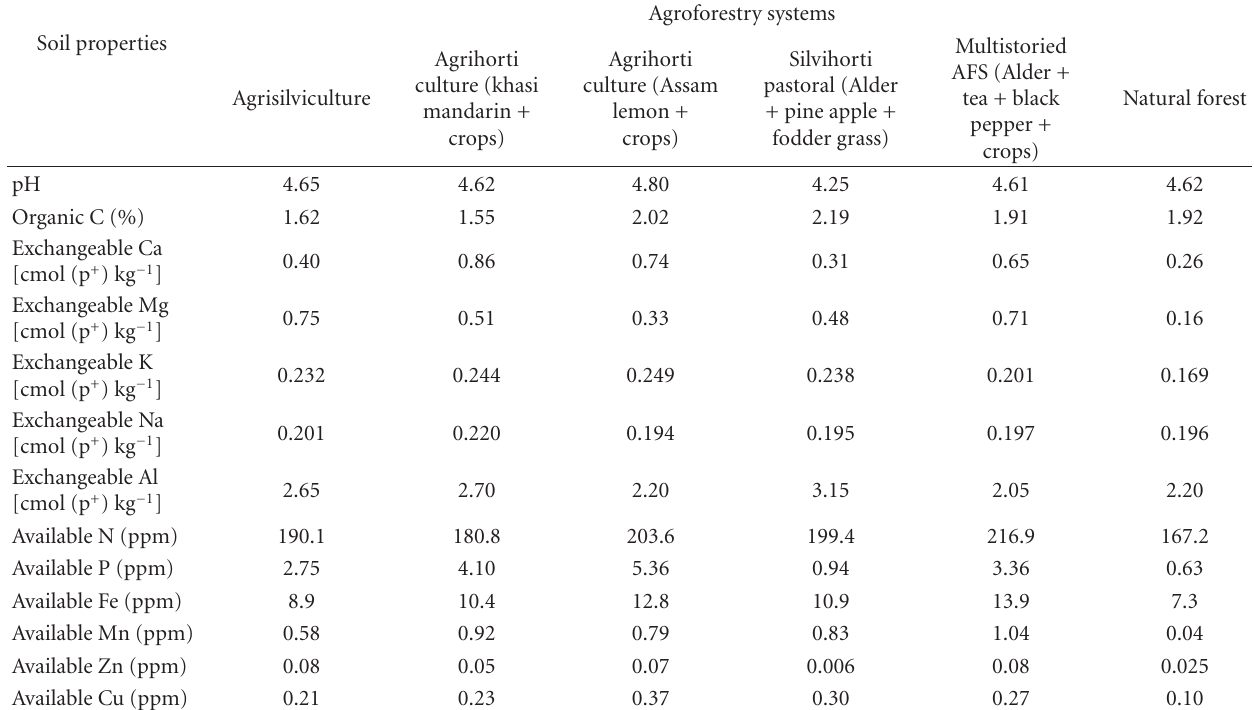
Table 3: E ff ect of agroforestry systems on soil